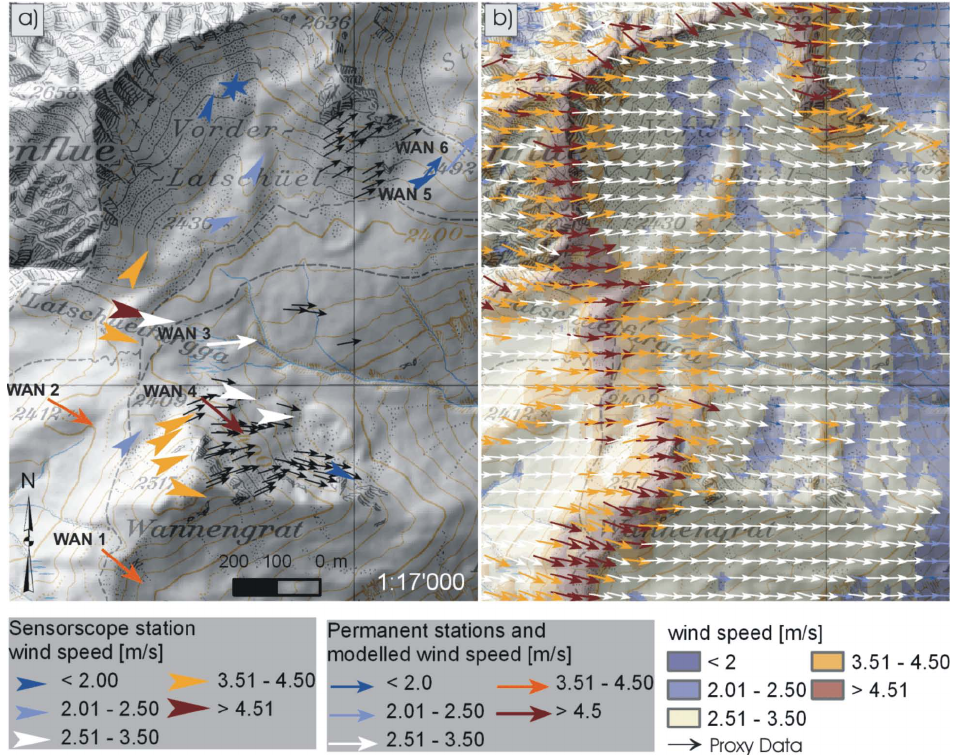
Fig. 4. Wind field measured by SensorScope and permanent stations (a) averaged for 24h (28 January 2010; P3 0910 ). Proxy data from snow-surface structures measured after the snowfall event P1 0910 are shown by black wind vectors. Modeled wind field for the first level above ground initialized with 2ms − 1 at 2400ma.s.l. (b) . Note that the grid spacing of the model results is 5m, but only one vector every 30m is illustrated. (basemap: Pixelkarte PK 25 ©2009 swisstopo (dv033492)). described above are indicated with black arrows. The